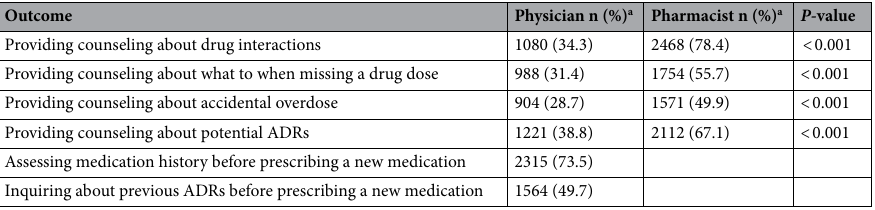
Table 5. Counseling provided by healthcare providers regarding elements of medication use. a Sometimes the cumulative percentages may not reach 100% due to missing values. When missing values are less than 10%, they were not reported